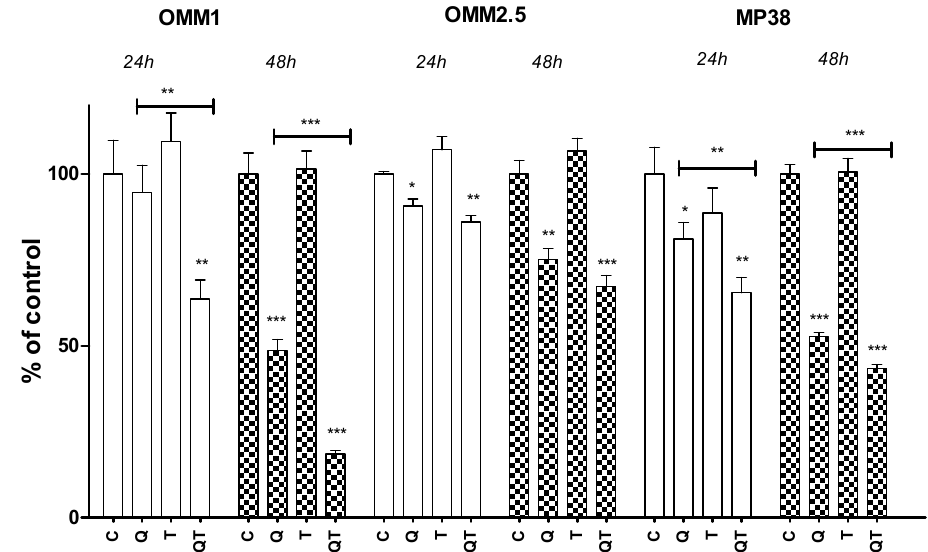
Figure 3. Cell numbers of three uveal melanoma cell lines after 48 h of treatment with Quisinostat or Tazemetostat of uveal melanoma cell lines. Cell density was determined using a cell titer blue assay. C: control; Q: 40 nM Quisinostat; T: 5 µ M Tazemetostat; QT: combination of 40 nM Quisinostat and 5 µ M Tazemetostat. * p ≤ 0.5, ** p < 0.01, *** p < 0.001. Error bars indicate the standard error of the mean.